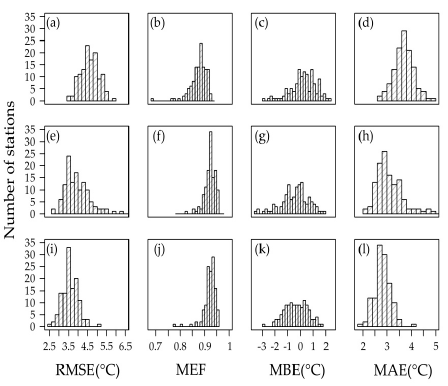
Figure 6. ( a – l ) T max , T min, and T mean model performance distribution for all the meteorological stations used: RMSE ( a , e , i ); MEF ( b , f,j ); MBE ( c , g , k ) and MAE ( d , h , l ).